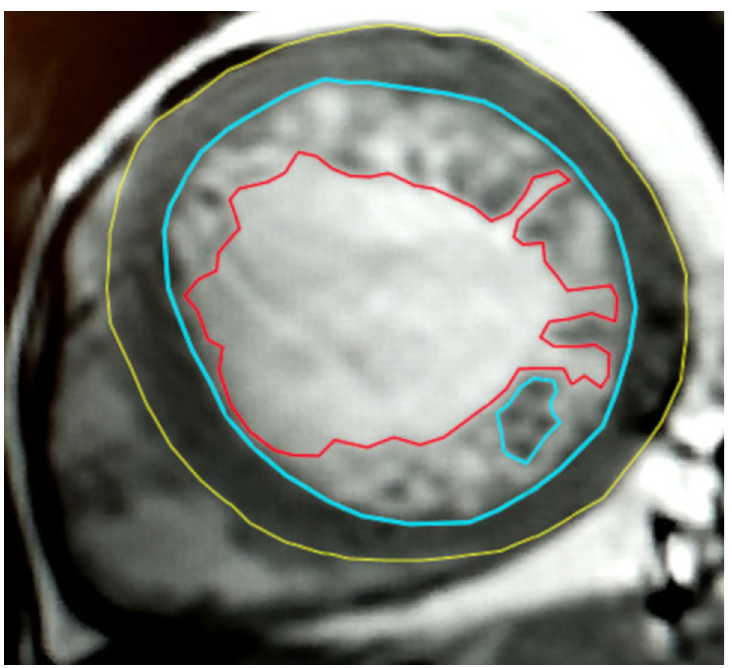
Fig 1. Diagnostic scheme of a noncompacted layer mass assessment by Jaquier’s method. Contours: epicardial (yellow), endocardial (blue), inner endocardial (red); the left ventricular compacted layer is between the epicardial (yellow) and endocardial (blue) contours, and the noncompacted layer is between the endocardial (blue) and inner endocardial (red) contours.